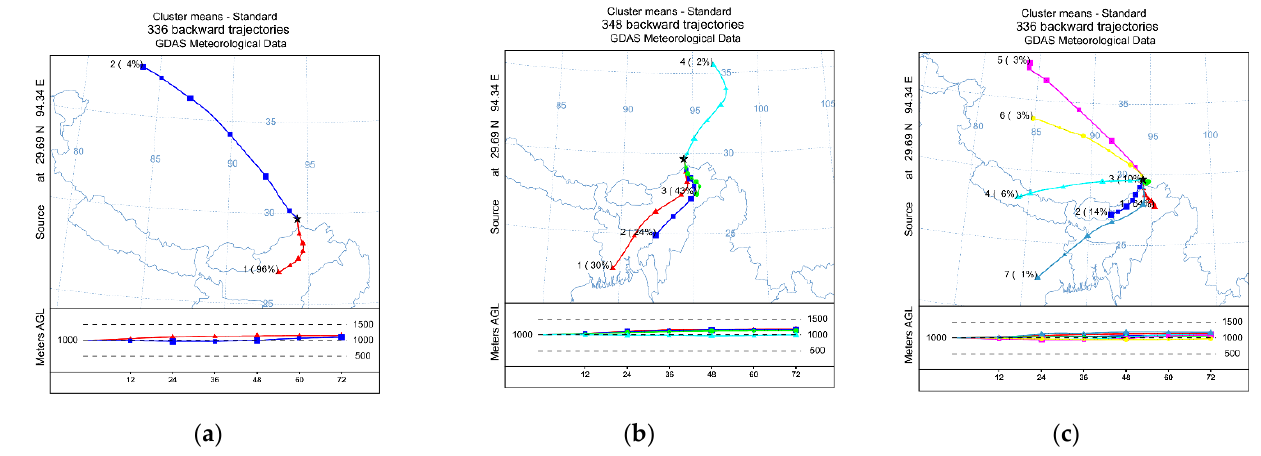
Figure 3. The 72-hour backward trajectories in the research area in different seasons. ( a ) — spring; ( b ) — summer; ( c ) — autumn. Cluster analysis was performed using the trajectories based on the total spatial variance (TSV) method.